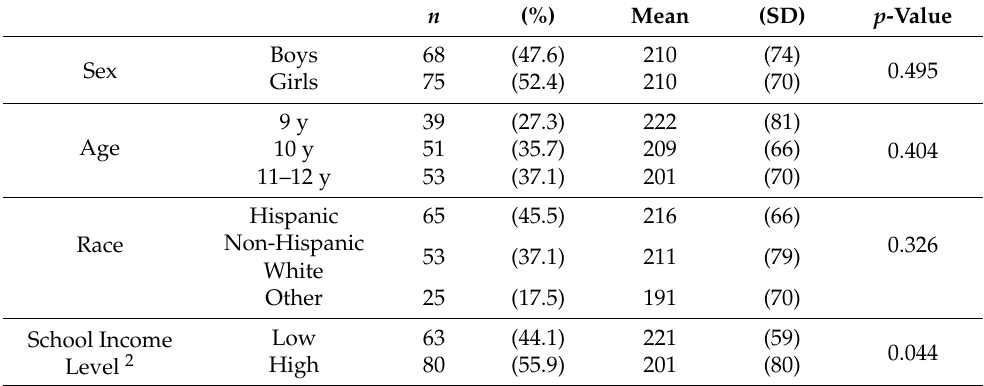
Figure 1. Distribution of Veggie Meter scores in a diverse sample of elementary school children ( n = 143). Table 1. Mean Veggie Meter (VM) scores by demographic characteristics of the sample ( n = 143) 1